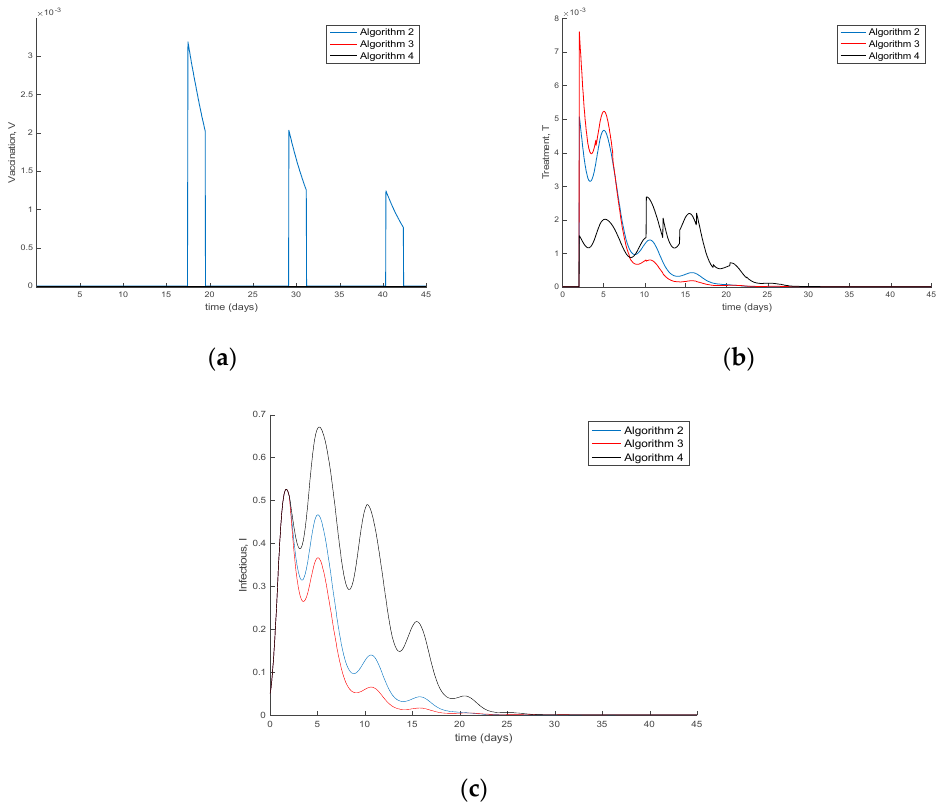
Figure 10. Comparison of the performances obtained by Algorithms 2–4. ( a ) Vaccination functions. ( b ) Treatment functions. ( c ) Comparison of the evolution of Infectious.